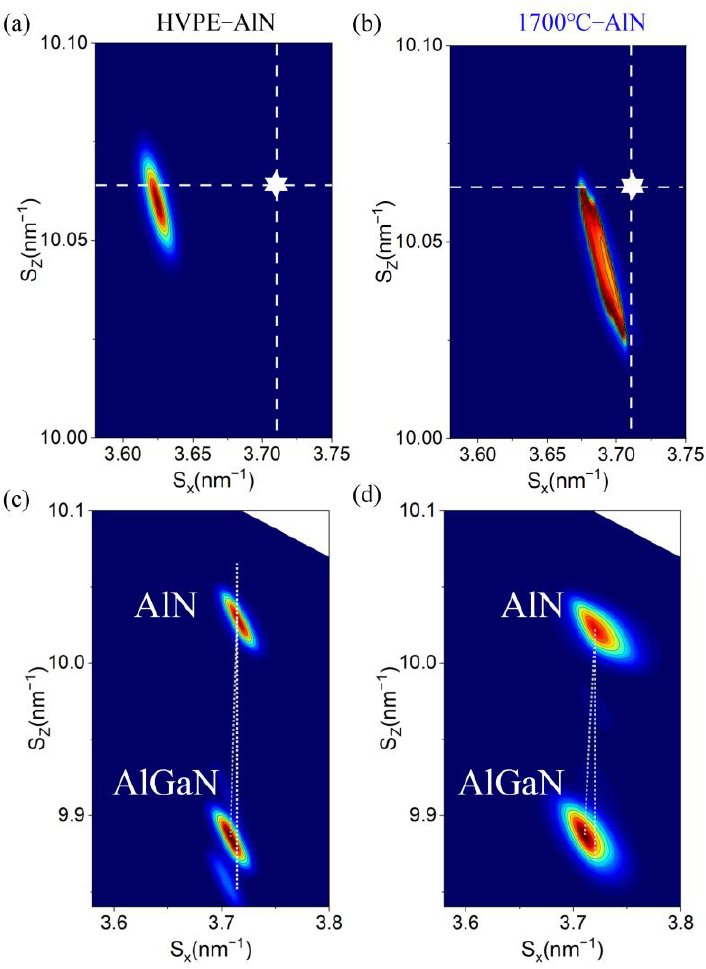
Figure 5. XRD-RSM results of AlN samples before and after high-temperature annealing: ( a ) the unannealed HVPE-AlN sample; ( b ) the high-temperature annealed sample at 1700 °C; ( c ) AlGaN on the unannealed HVPE-AlN sample; ( d ) AlGaN on the high-temperature annealed sample at 1700 °C.